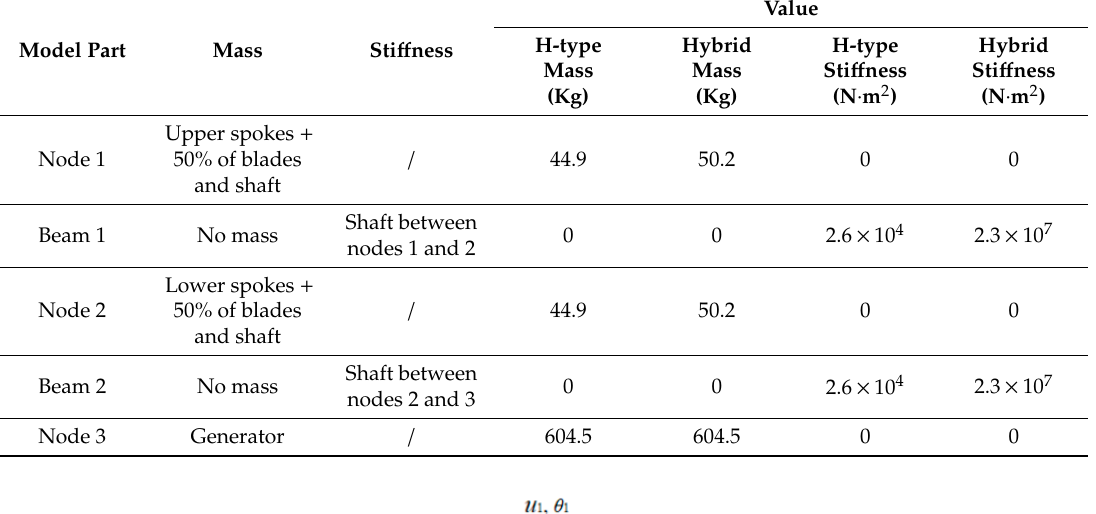
Table 1. Mass and sti ff ness values of the simplified MDOF turbine model.